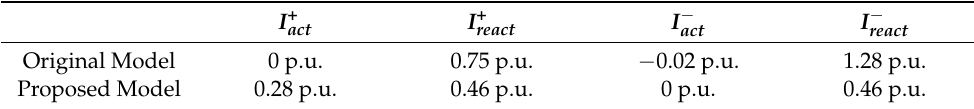
Table 5. Summary of the results obtained during the